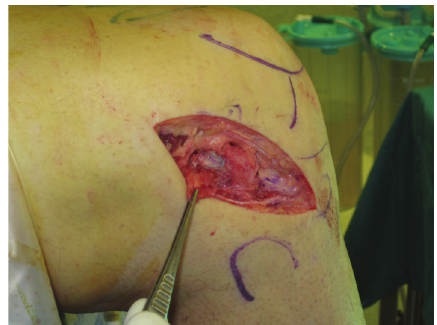
Figure 5: Final image of the tenodesis before